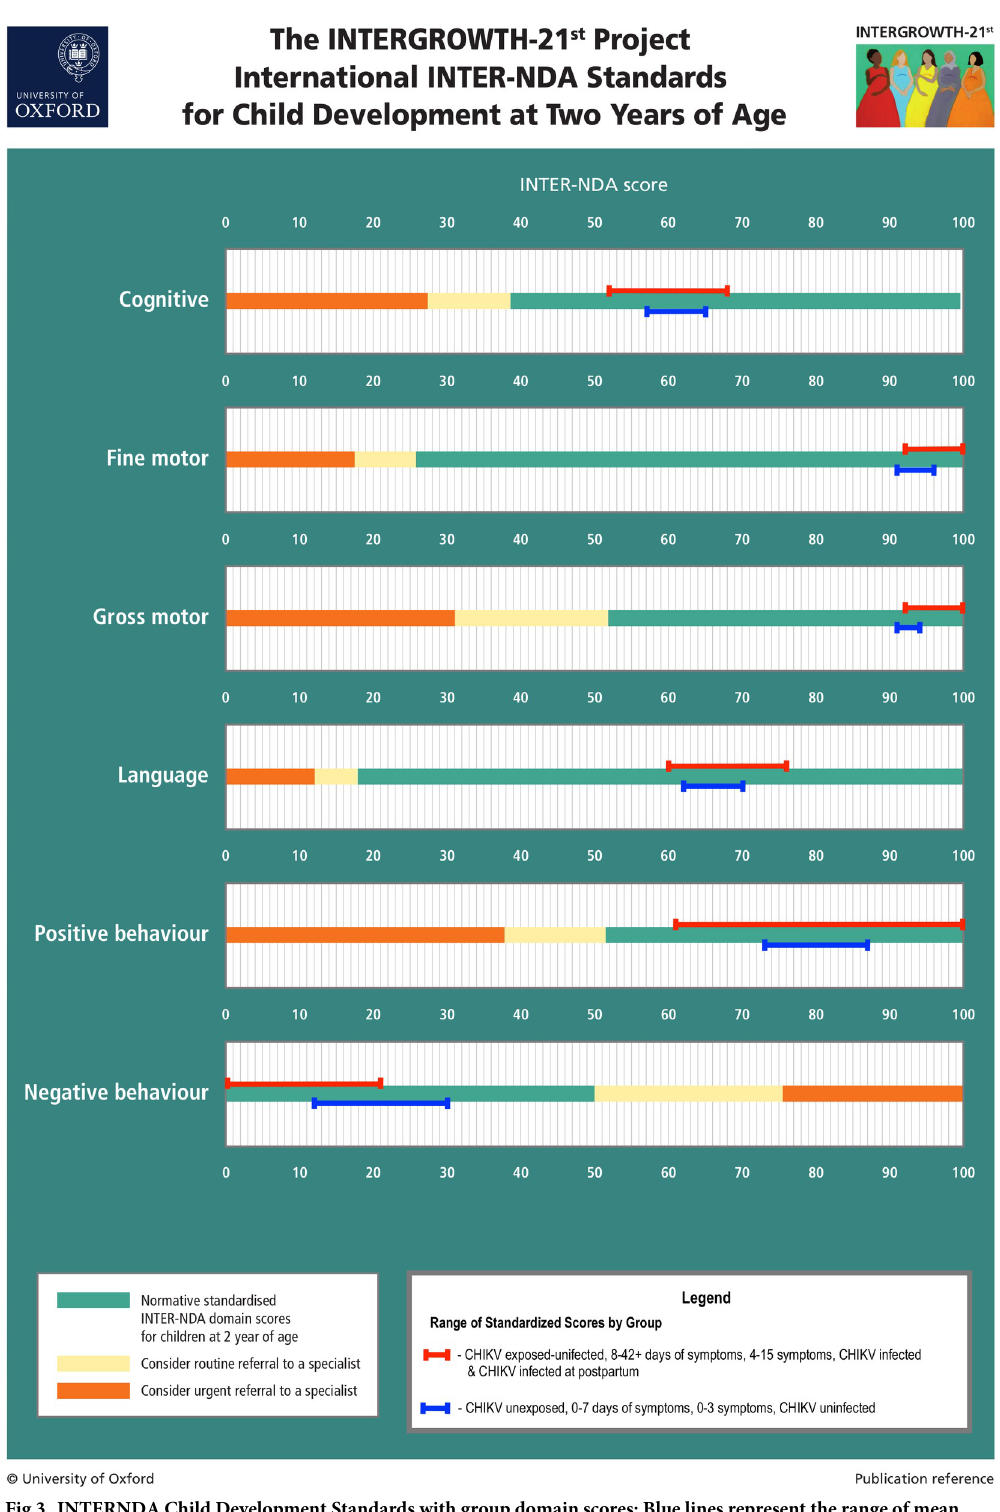
Fig 3. INTERNDA Child Development Standards with group domain scores: Blue lines represent the range of mean standard scores across CHIKV unexposed/uninfected children and children born to mothers with fewer symptoms and shorter symptom duration. Red lines represent the range of mean standard scores across CHIIKV exposed/infected children and children born to mothers with greater symptoms and longer symptom duration. All mean standardized